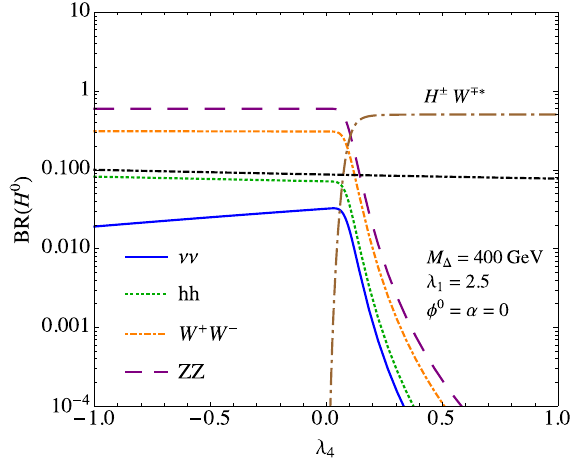
Figure 15 . BRs for H 0 decay into (cid:23)(cid:23) , hh , W + W (cid:0) , ZZ , and H (cid:6) W (cid:7)(cid:3) , where (cid:30) + = (cid:11) = 0, M (cid:1) = 400 GeV, and (cid:21) 1 = 2 : 5 are used.